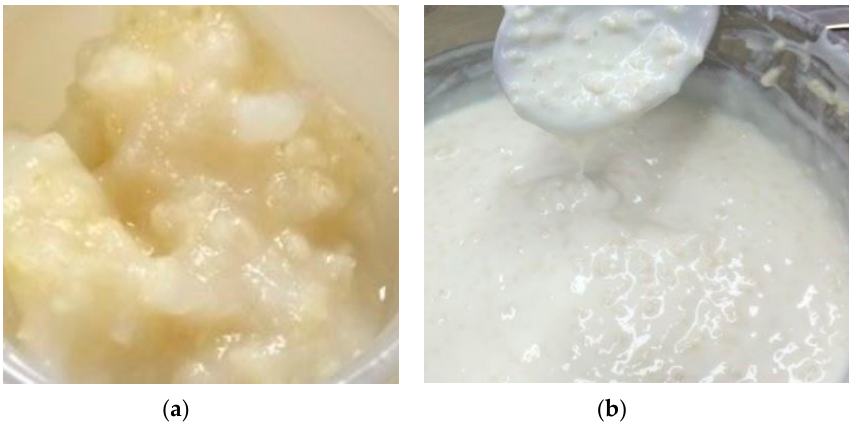
Figure 2. ( a ): 8% millet in water, 5% sucrose, 60-min pre-treatment, 12 h fermentation (40 °C); ( b ): 4% Figure 2. ( a ) 8% millet in water, 5% sucrose, 60-min pre-treatment, 12 h fermentation (40 ◦ C); ( b ) 4% millet in milk, 60-min pre-treatment, 12 h fermentation (40 °C). millet in milk, 60-min pre-treatment, 12 h fermentation (40 ◦